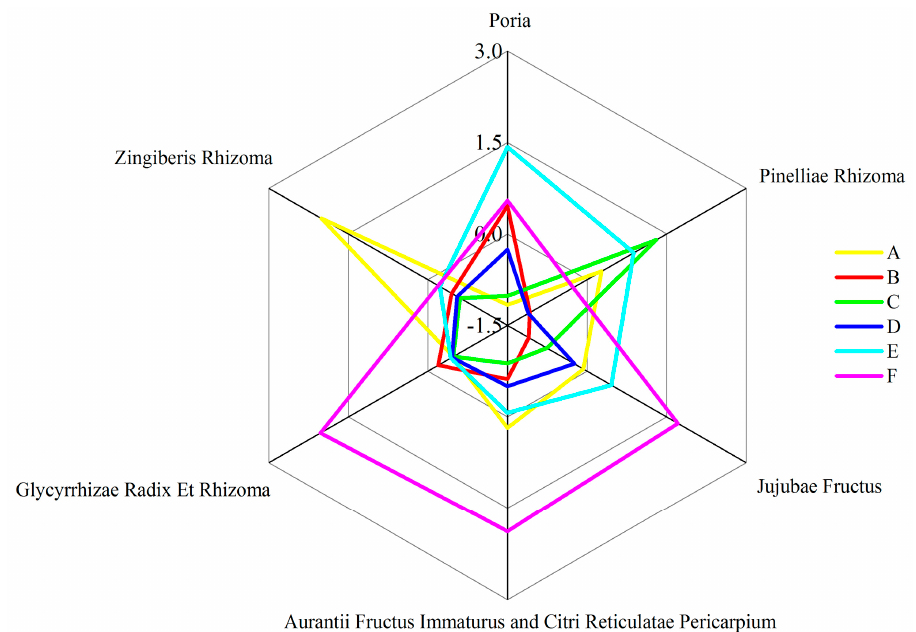
Figure 5. The radar chart of z-score normalized data of "total daily dosage of measured ingredients" of the seven pieces of traditional Chinese medicine in six WDD preparations. The daily dosage of Zingiberis Rhizoma is expressed as the sum of the mean daily dosages of 6-gingerol, 8-gingerol and 10-gingerol. The daily dosage of Pinelliae Rhizoma is revealed as the mean daily dosages of succinate. The daily dosage of Jujubae Fructus is illustrated as the mean daily dosages of rutin. The daily dosage of Glycyrrhizae Radix Et Rhizoma is demonstrated as the sum of the mean daily dosages of liquiritin, isoliquiritin and liquiritigenin. The daily dosage of Poria is displayed as the sum of the mean daily dosages of pachymic acid and dehydropachymic acid. The daily dosage of Aurantii Fructus Immaturus and Citri Reticulatae Pericarpium is shown as the sum of the mean daily dosages of synephrine, eriocitrin, narirutin, naringin, hesperidin, neohesperidin, didymin, poncirin and